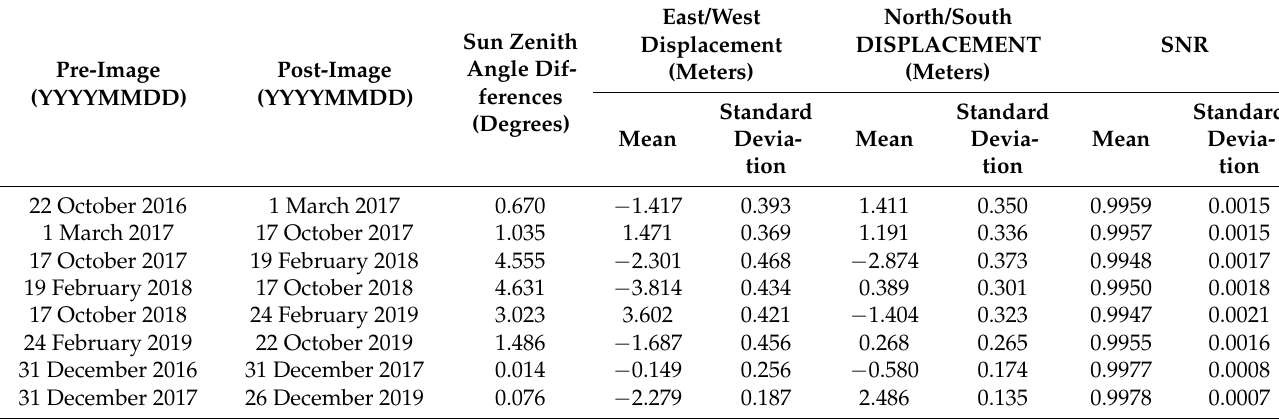
Table 3. Mean and standard deviation of displacements and SNR in the stable area of each Sentinel-2A/B image pair.